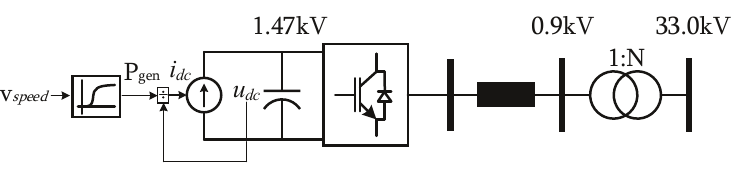
Figure 3. Equivalent wind turbine model.